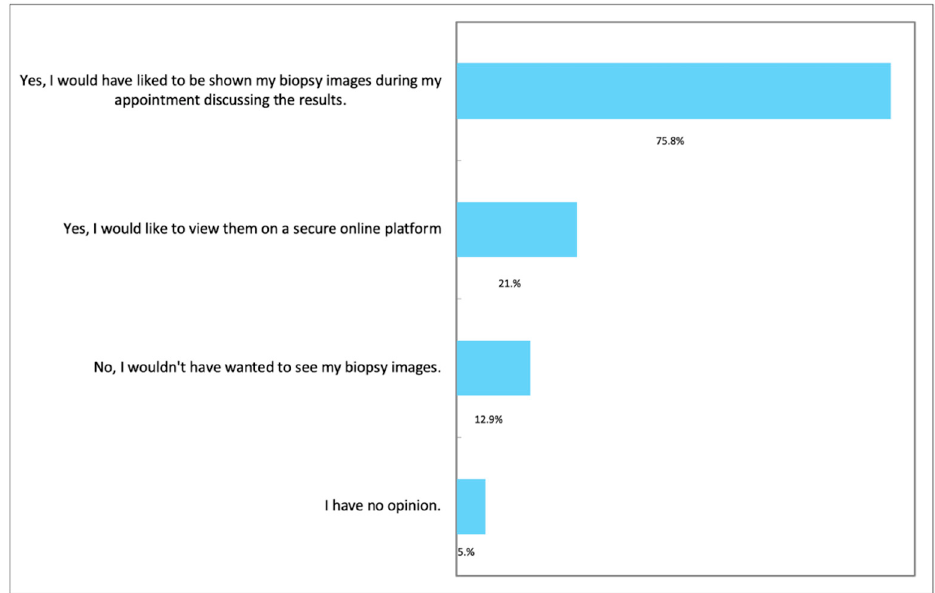
Figure 3. Respondents’ views on viewing digital biopsy images (please see online supplementary material, Question S8). Respondents were able to choose more than one option.